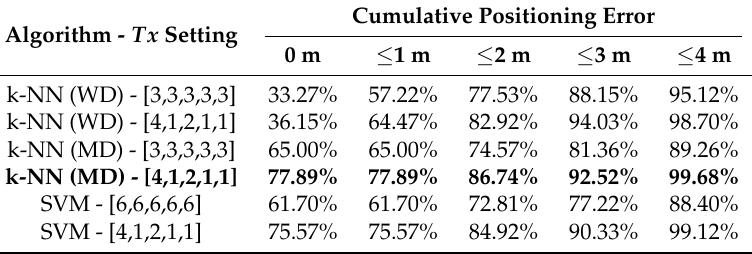
Table 6. Cumulative positioning error with different transmission power ( Tx ) level settings for k-NN (with k = 5) using weighted distance (WD) and mode (MD); and SVM (with a quadratic polynomial kernel function). Best results are shown in bold.